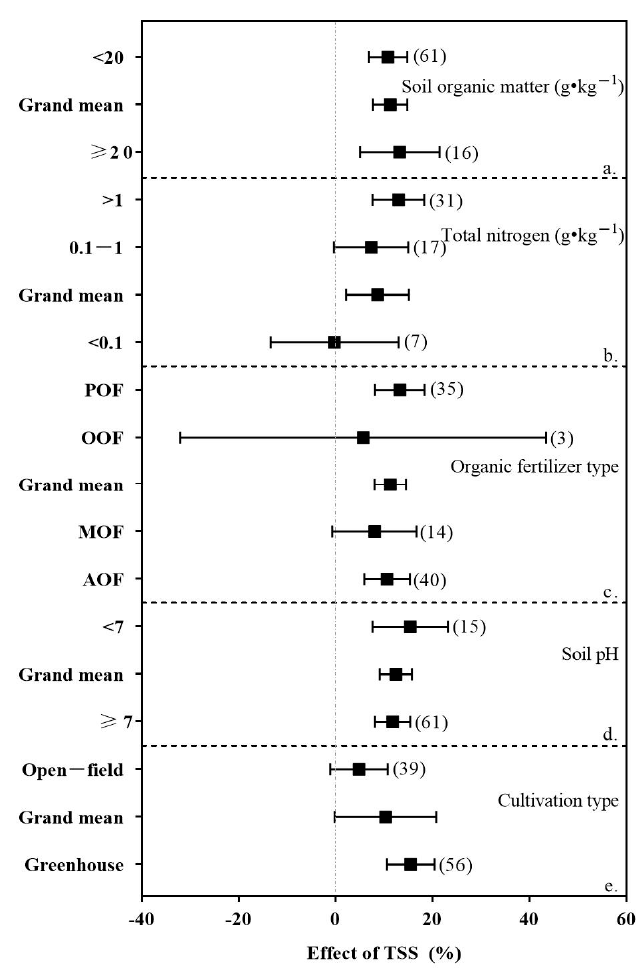
Figure 5. Organic fertilizers combined with soil organic matter ( a ), total soil nitrogen ( b ), type of organic fertilizers ( c ), soil pH ( d ), and cultivation type ( e ) on tomato TSS (total soluble solids) percentage changes. Points represent the mean effect, while bars represent 95% confidence intervals. The numbers on the right side of the confidence intervals represent the sample sizes. AOF, animal organic fertilizer; MOF, mixed animal-and-plant organic fertilizer; POF, plant organic fertilizer; OOF, other organic fertilizer.